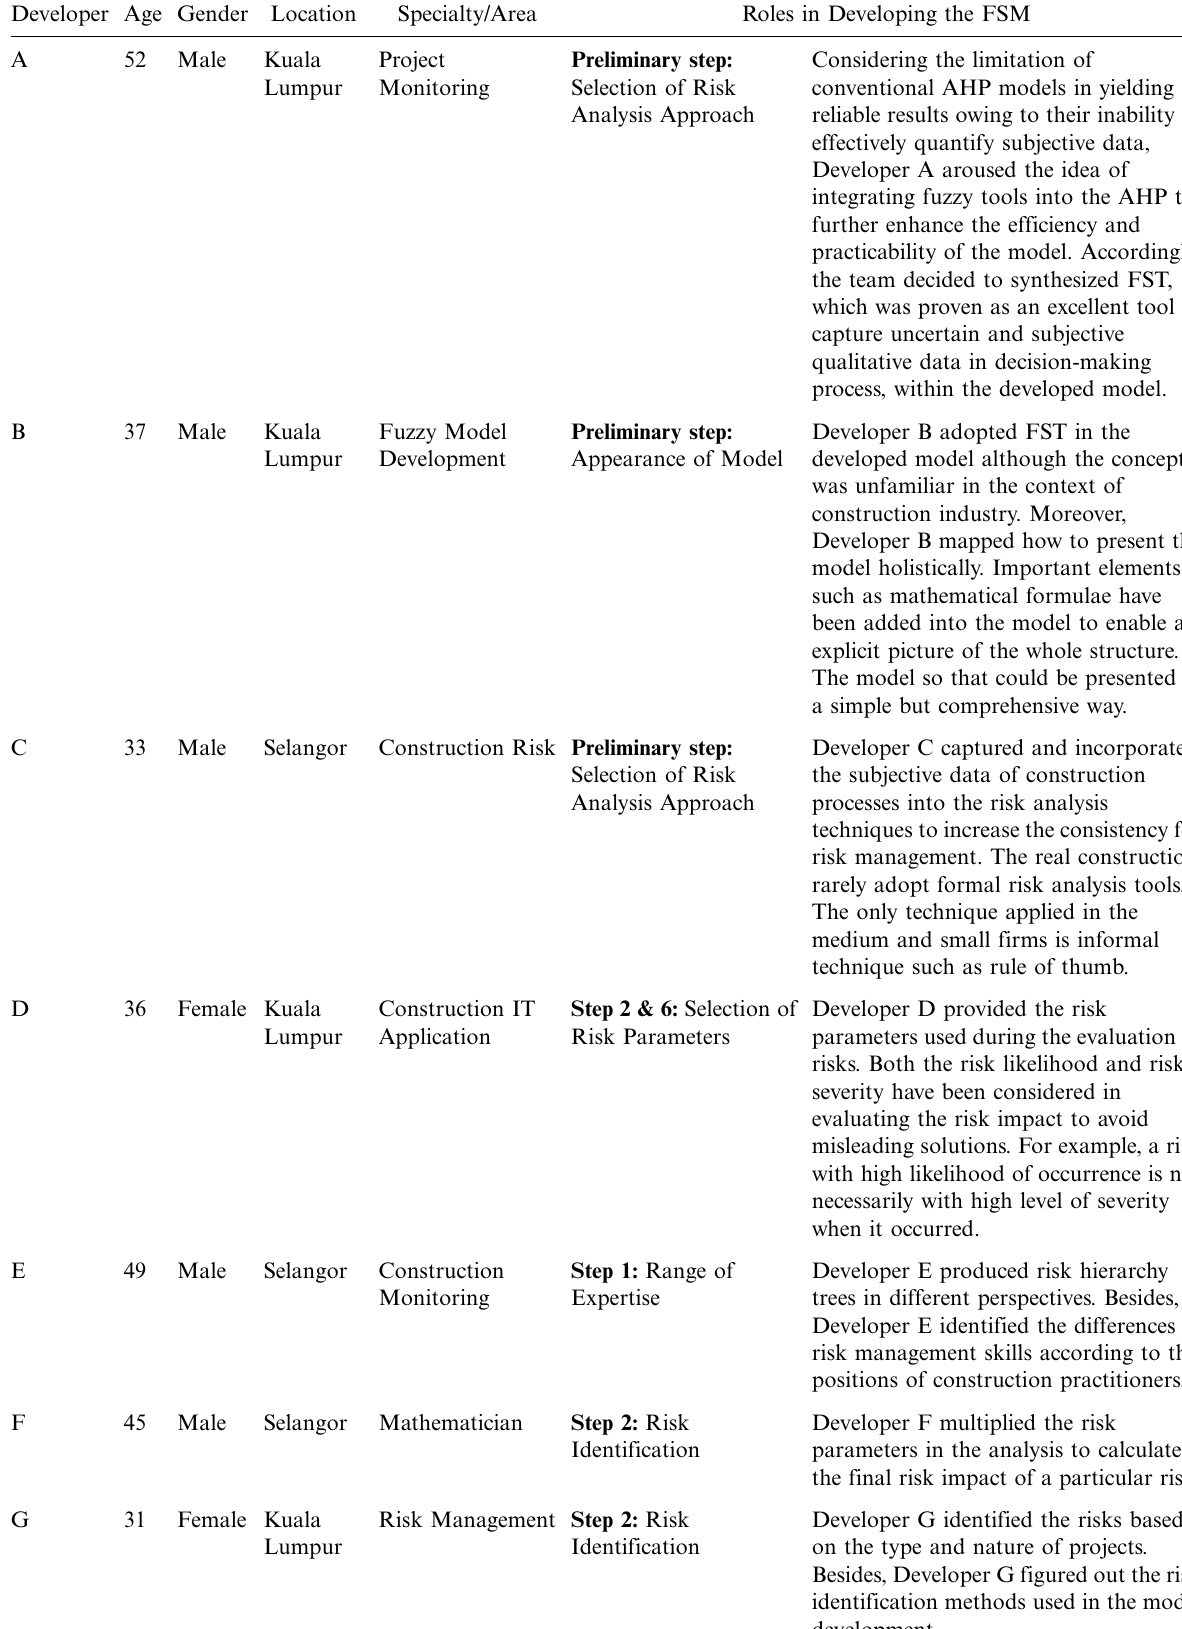
Table 3. Developers’ profiles and roles in the development of FSM Developer Age Gender